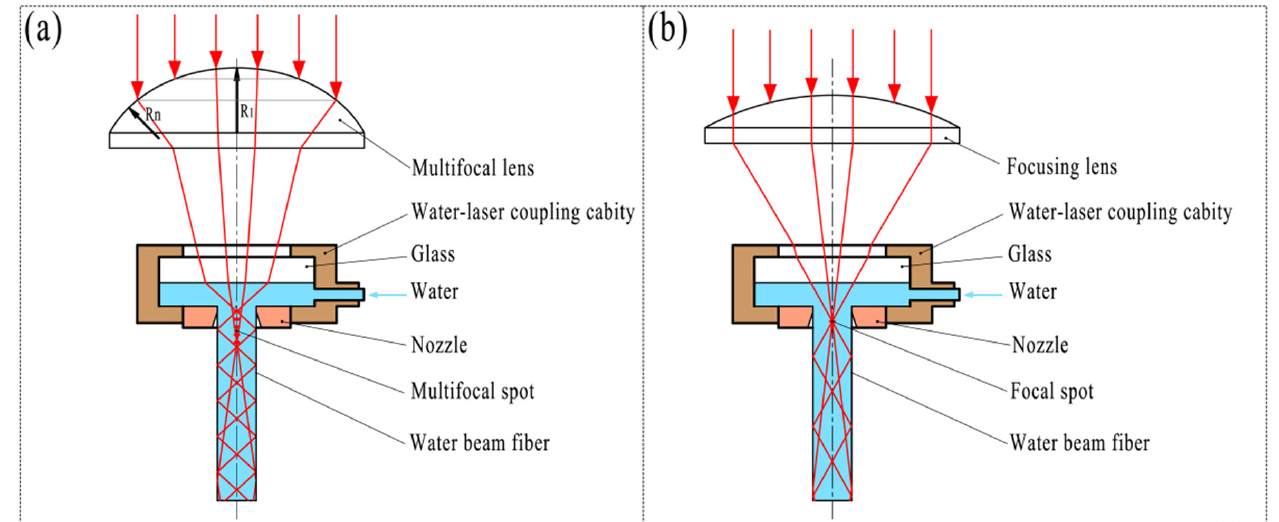
Figure 1. Schematic diagram of waterjet-guided laser coupling principle. ( a ) Multifocus coupling; ( b ) Single-focus coupling.